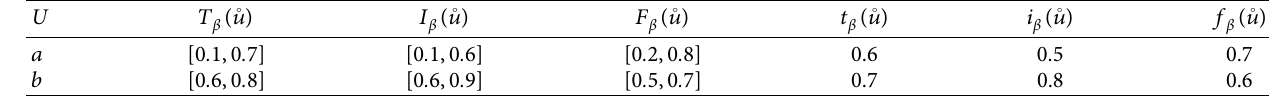
Table 2: Neutrosophic cubic set β of U.